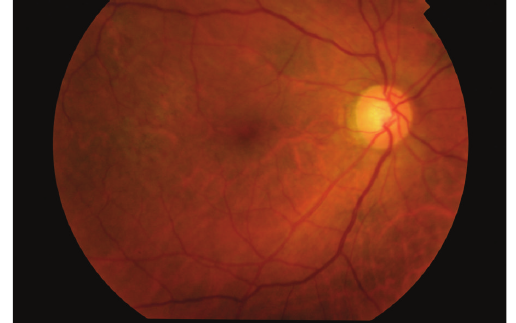
Figure 3: Two weeks after surgery, his best-corrected visual acuity (BCVA) was 20/100 with no hemorrhage and retina was